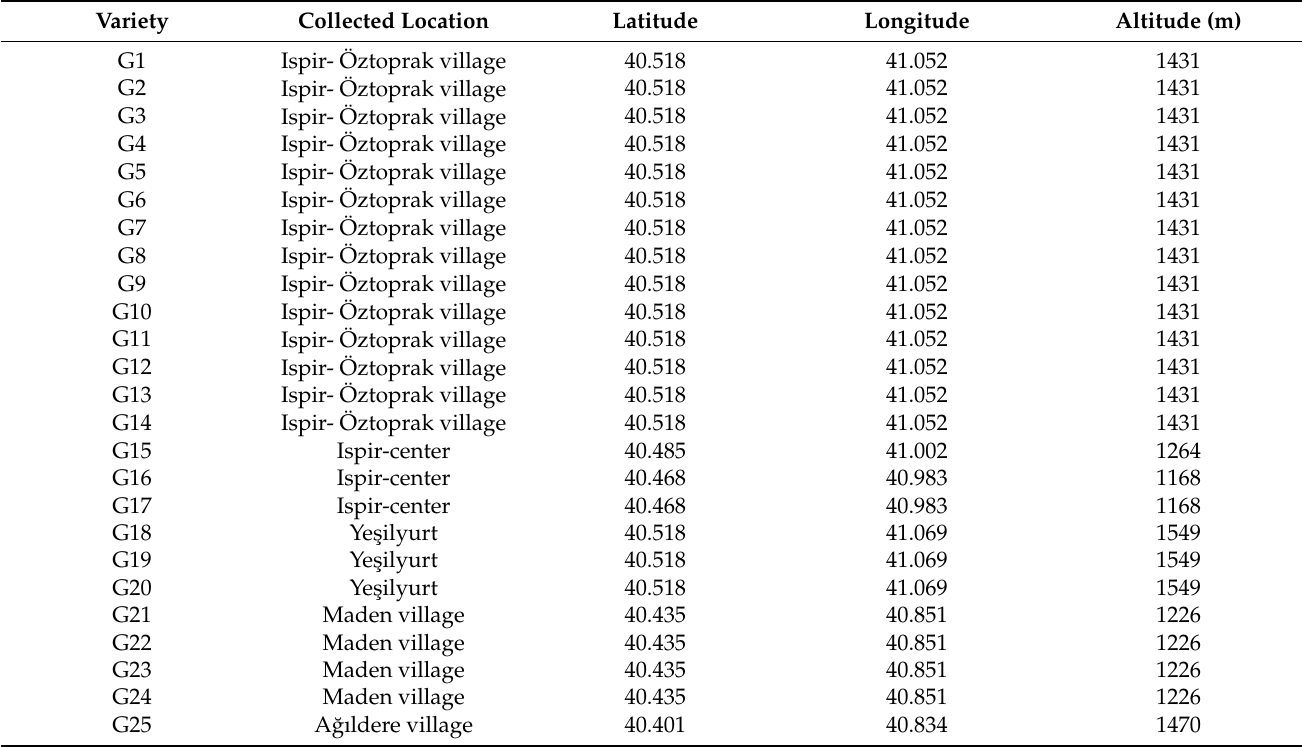
Table 1. List of beans ( P. vulgaris L.) local varieties and commercial cultivars collected from the Erzurum-Ispir district in